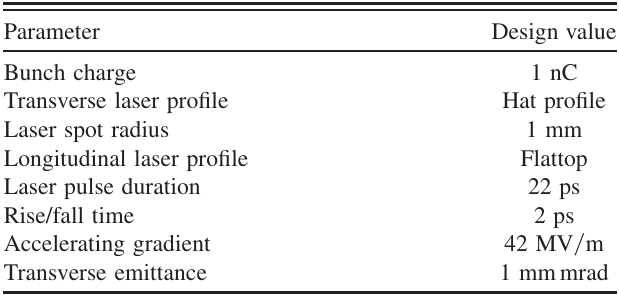
TABLE IV. PITZ design parameters.